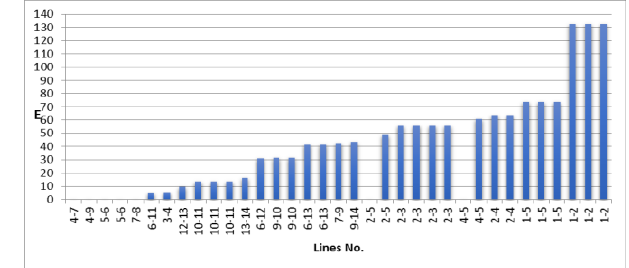
Fig5. Economic index after exclusion of less efficient line 2-5 Iteration 3: Exclusion of route 4-5 The average Ei of the system for existing number of lines from below figure after the exclusion of less efficient lines 2-5, 4-5 will be = 1419.4/29= 48.94 . Fig.6 shows the chart for E network with exclusion of route 4-5 from the network.